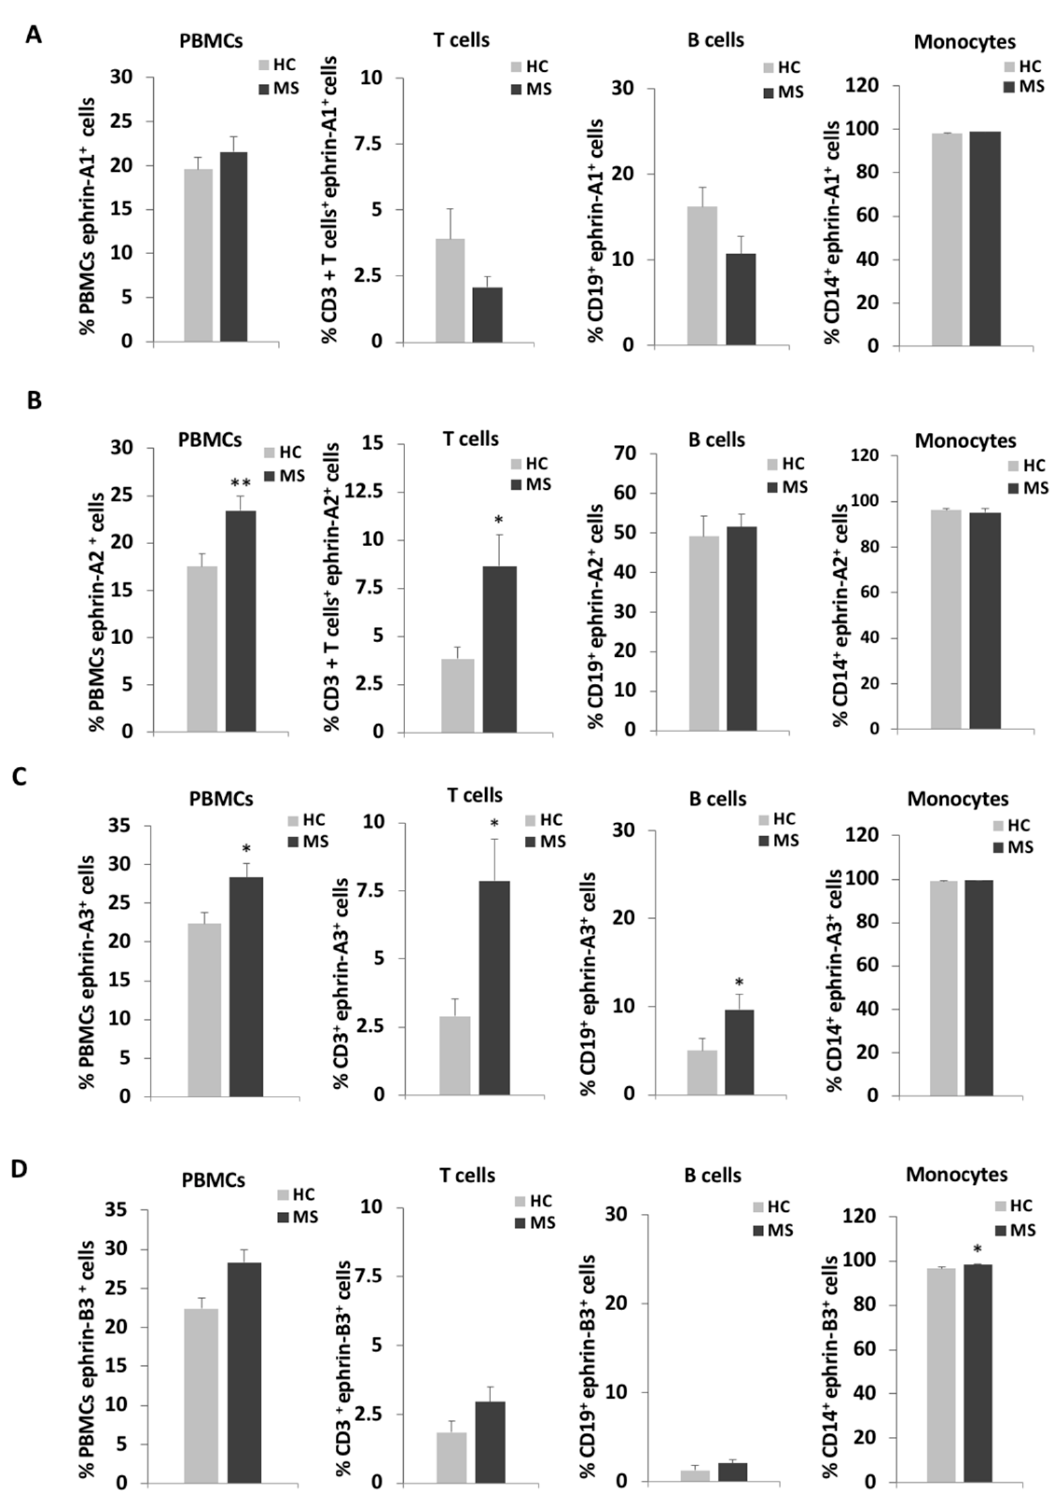
Figure 1. Ephrin expression levels on immune cells of patients with relapsing-remitting multiple sclerosis (RR-MS) and of healthy controls. Immune cells of patients with relapsing-remitting multiple sclerosis (MS) and of healthy controls (HC) were analyzed by flow cytometry for the percentages of expression of ephrin-A1 ( A ), ephrin-A2 ( B ), ephrin-A3 ( C ) and ephrin-B3 ( D ) on total PBMC, CD3 + T cells, CD19 + B cells and CD14 + monocytes. * p < 0.05, ** p <